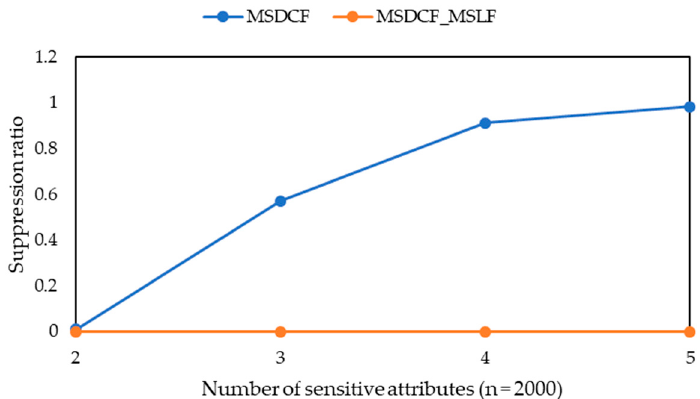
Figure 12. The suppression ratio of MSDCF and MSDCF-MSLF with different sensitive attribute numbers ( n = 2000).